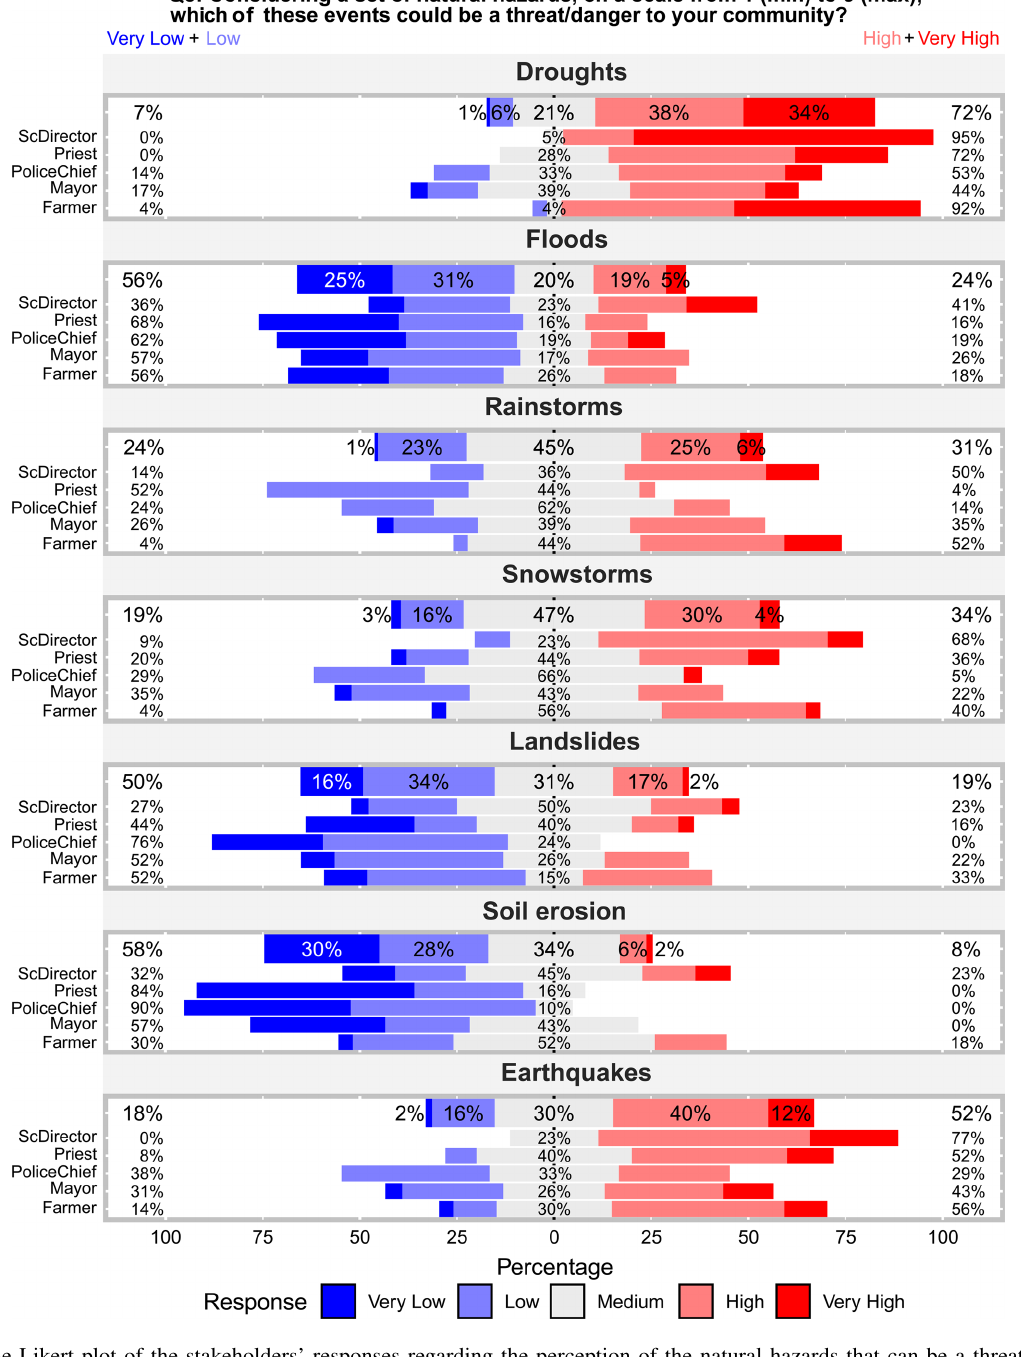
Figure 4. The Likert plot of the stakeholders’ responses regarding the perception of the natural hazards that can be a threat to the local community, split by natural hazard and stakeholder